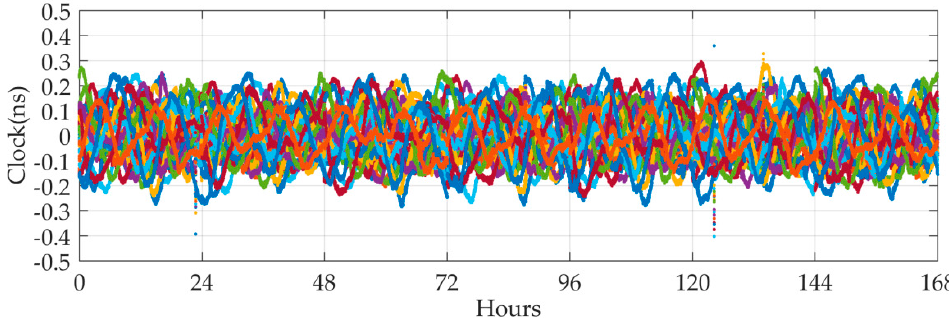
Figure 5. Time series of the MADOCA GPS satellite clock errors from 11 November 2018 to 17 November 2018.